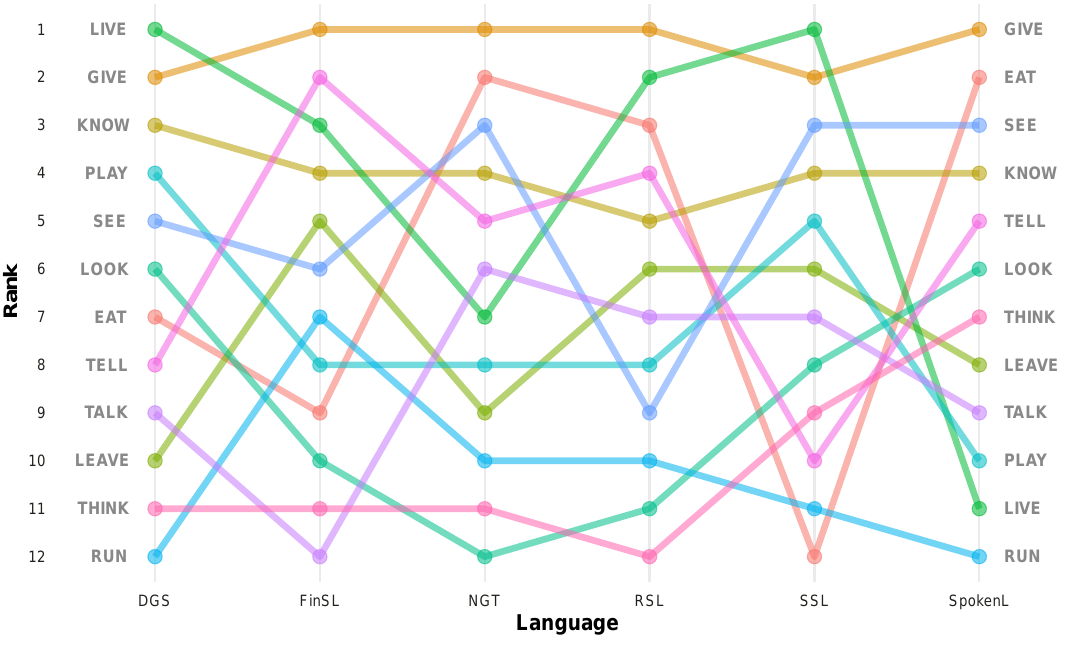
Figure 4: The rank of the 12 ValPaL meanings in the five sign languages in terms of their transitivity proportions and the spoken languages from Haspelmath (2015). Locative arguments are included for the sign languages.